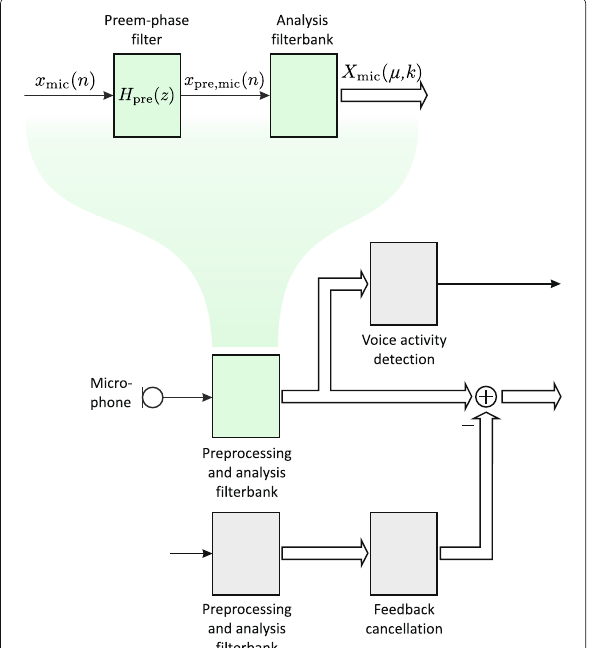
Fig. 6 Structure of the preprocessing andanalysis filterbank stage